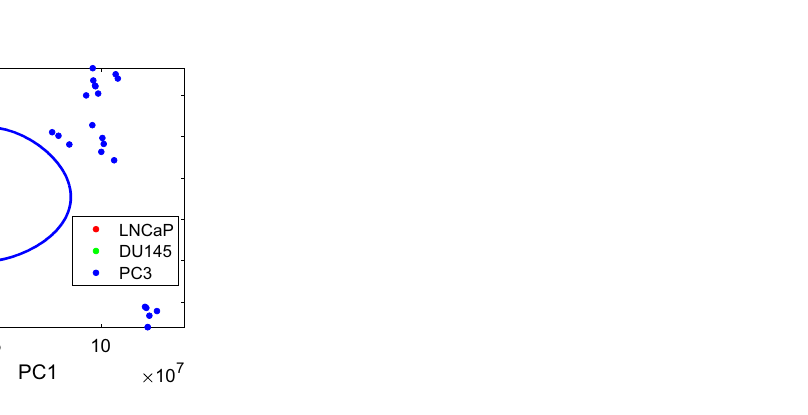
Figure 4. A multi-class SVM